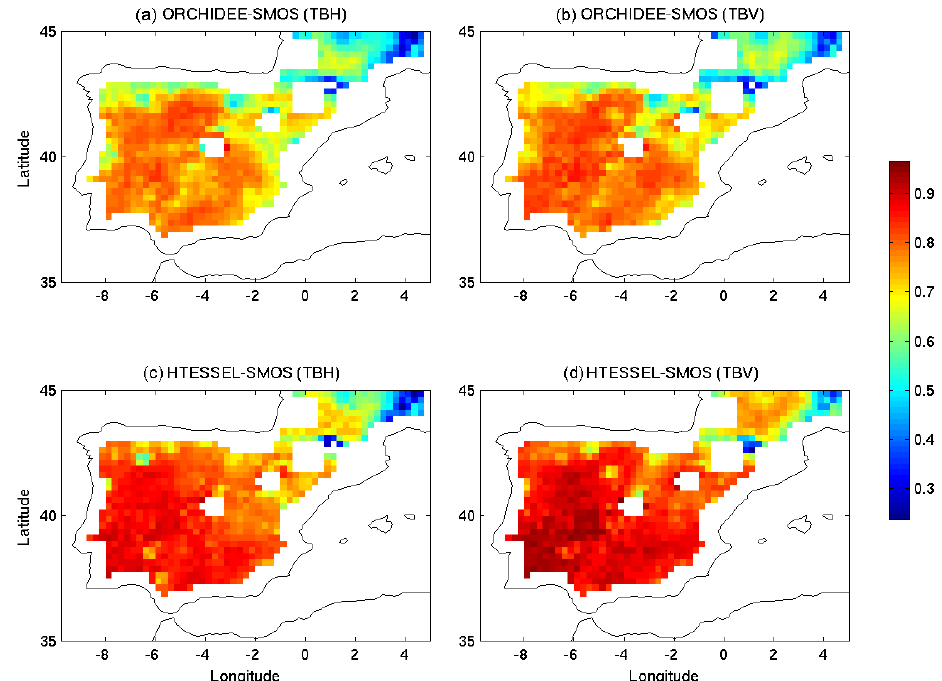
Figure 1. Temporal correlation between modelled and measured TBs from 2010 to 2012. TBH and TBV correspond to the horizontal and vertical polarizations, respectively.